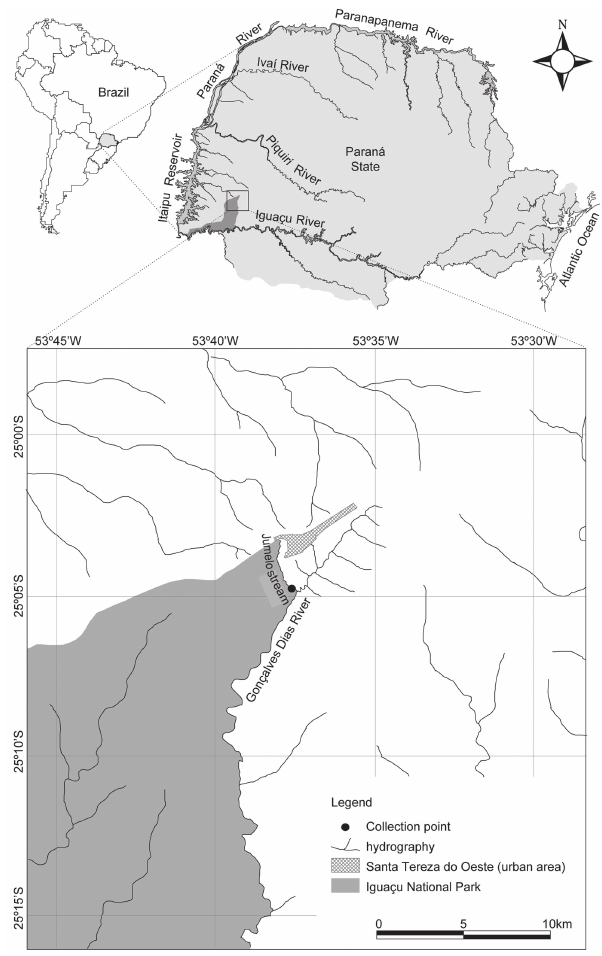
Fig. 1. Study area. Collection point in stream Jumelo, region of the Iguaçu National Park in the Brazilian state of Paraná and Gonçalves Dias River in the Iguaçu River Basin, Santa Tereza do Oeste,